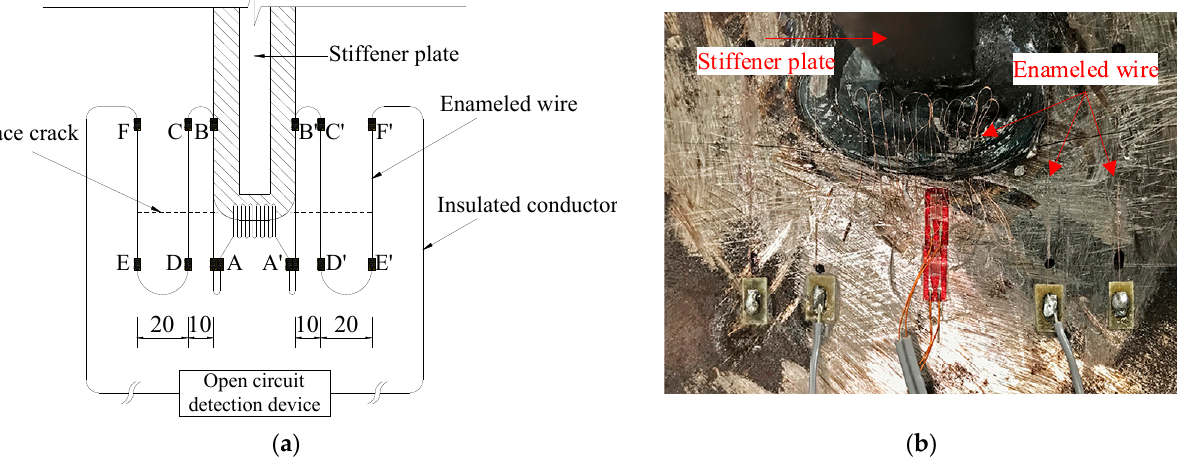
Figure 5. Surface crack monitoring. ( a ) Control circuit (mm). ( b ) Arrangement of enameled wires at the end weld.